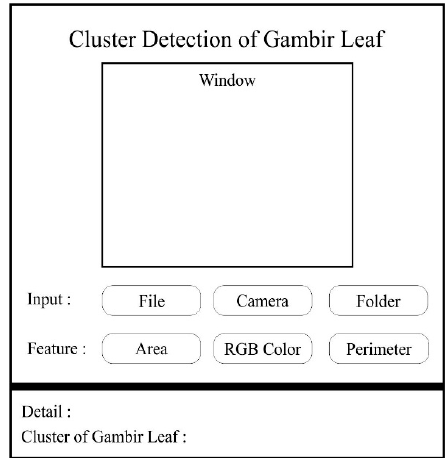
Figure 5. Software system